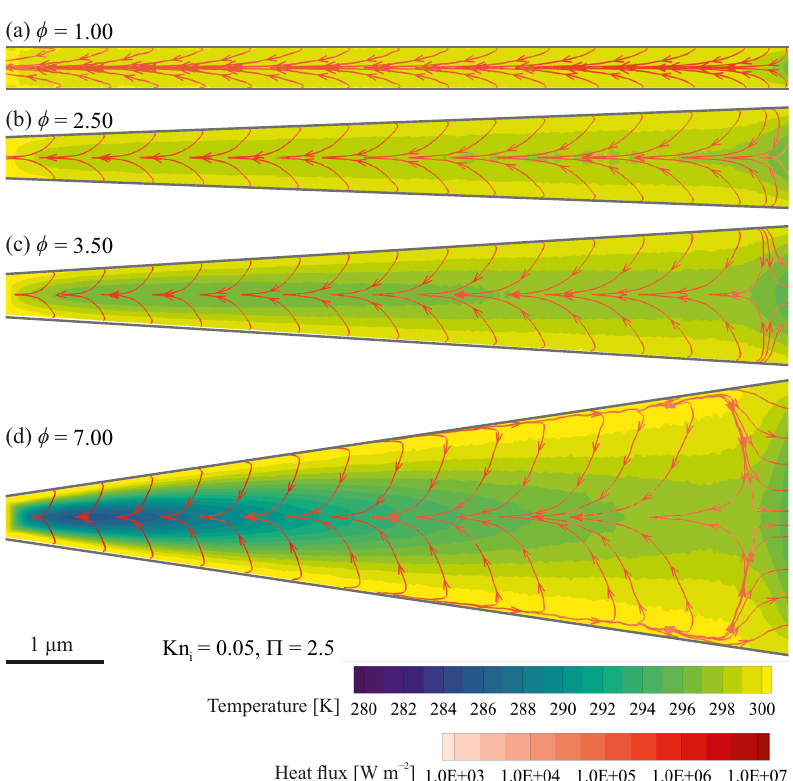
Figure 5. Contours of temperature overlaid with heatlines (coloured by the magnitude of heat flux) obtained from the simulations for microchannels with different divergence angles φ . (Kn i = 0.05 and Π =